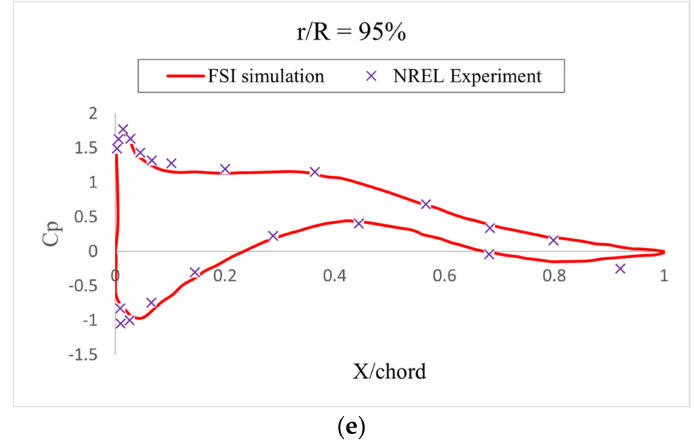
Figure 6. Pressure coefficient from the simulation and the experiment at five different spans along the blade: ( a ) Pressure coefficient at 30% span of the blade; ( b ) Pressure coefficient at 46.6% span of the blade; ( c ) Pressure coefficient at 63% span of the blade; ( d ) Pressure coefficient at 80% span of the blade; ( e ) Pressure coefficient at 95% span of the blade.